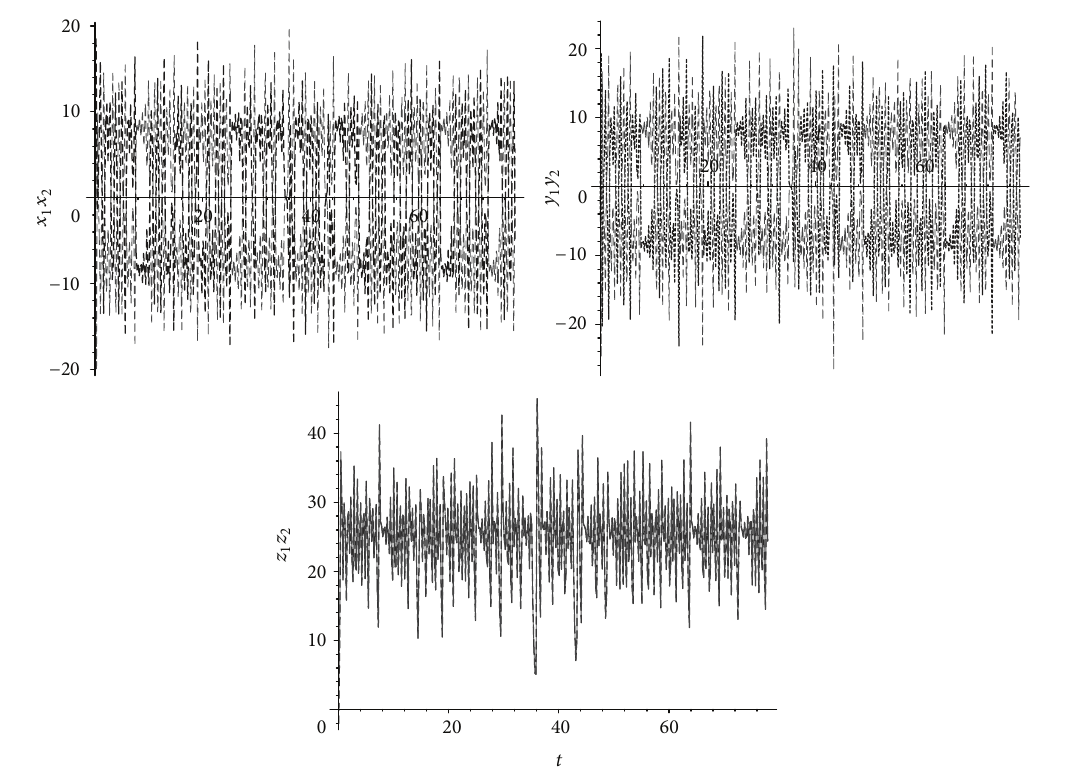
Figure 10: The temporal evolution of variables between node 1 (“ ⋅⋅⋅ ”) and node 2